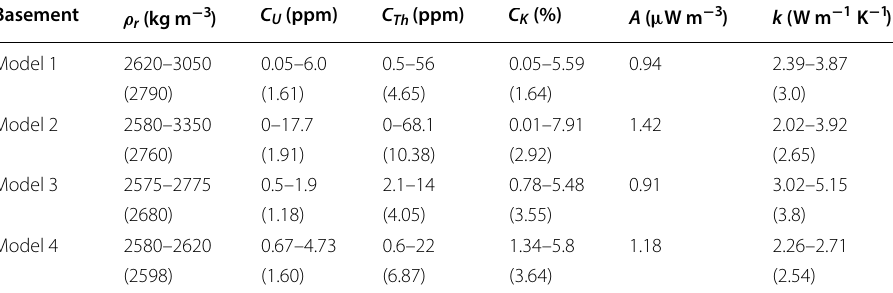
Table 6 Physical properties of Grenvillian rocks in the PM domain (Model 1), Shawinigan domain (Model 2), PDLD (Model 3) and from well cores (Model 4); average values in